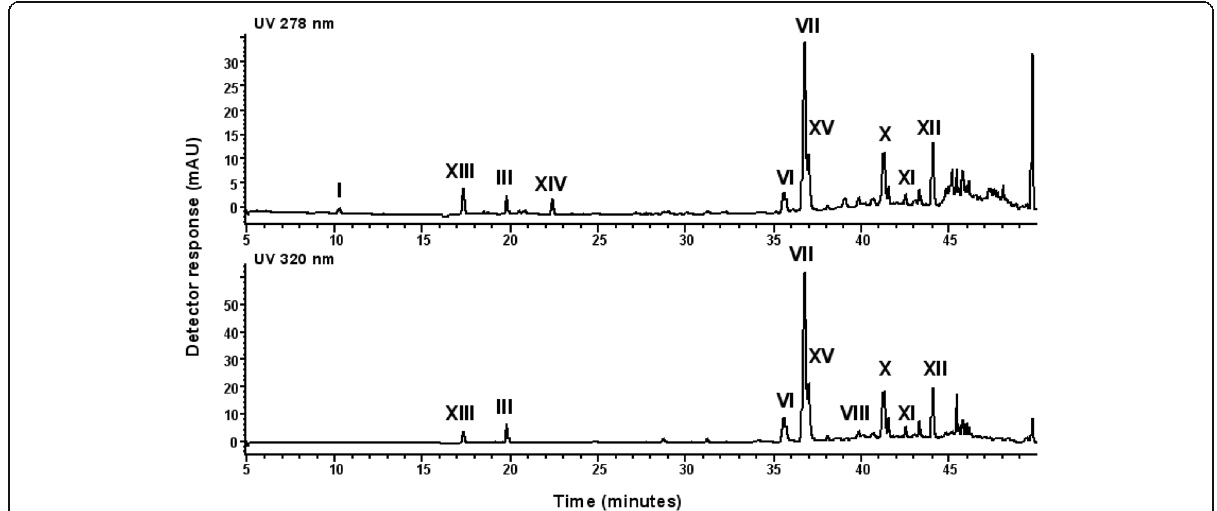
Fig. 2 Analytical HPLC chromatogram of an DCM extract of Melissa officinalis at 278 nm